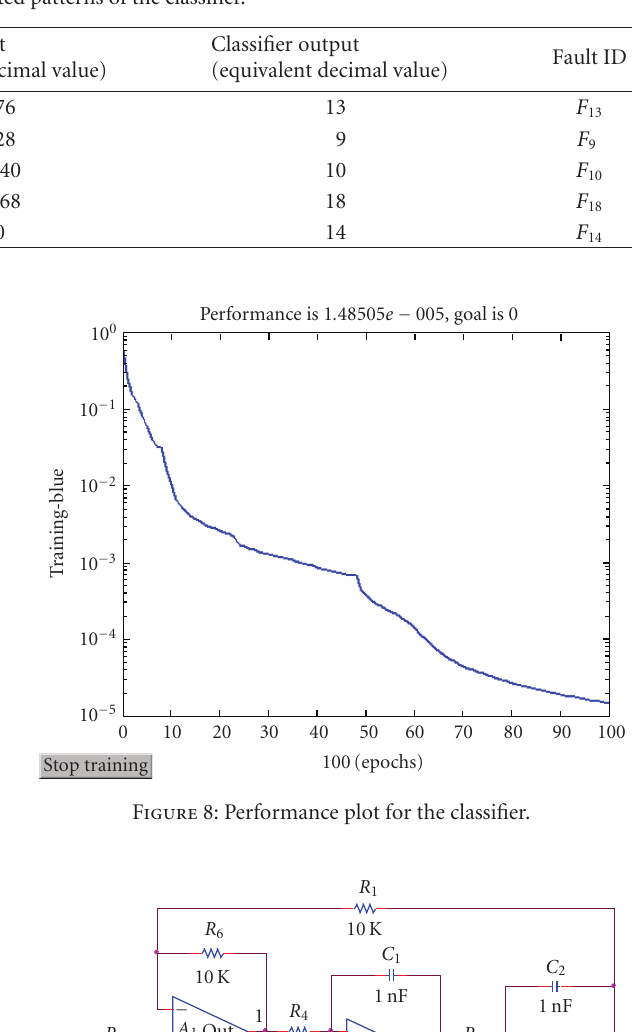
Table 4: Few random tested patterns of the classifier.